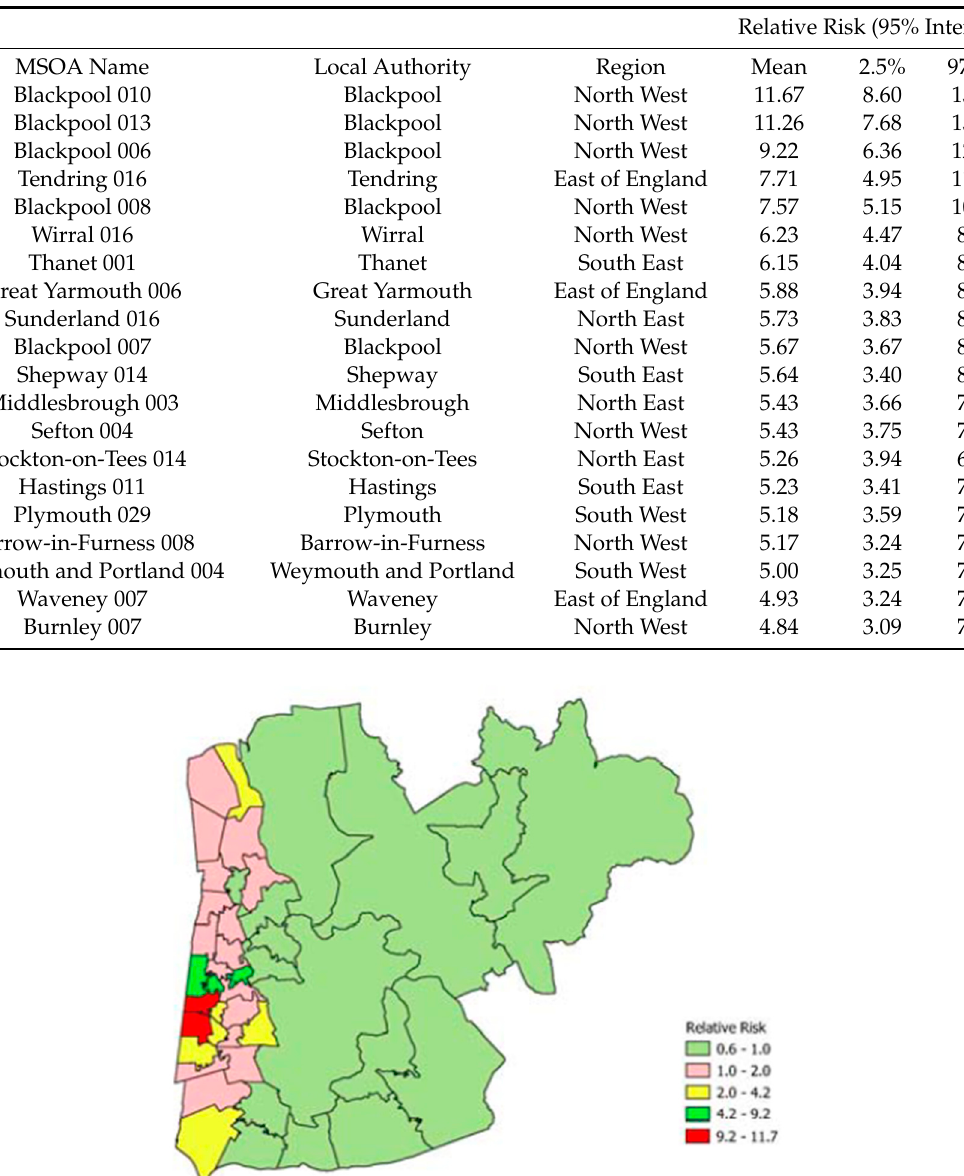
Table 7. MSOAs with Highest DRD Relative Risk, With Socio-Economic and Locational Details.